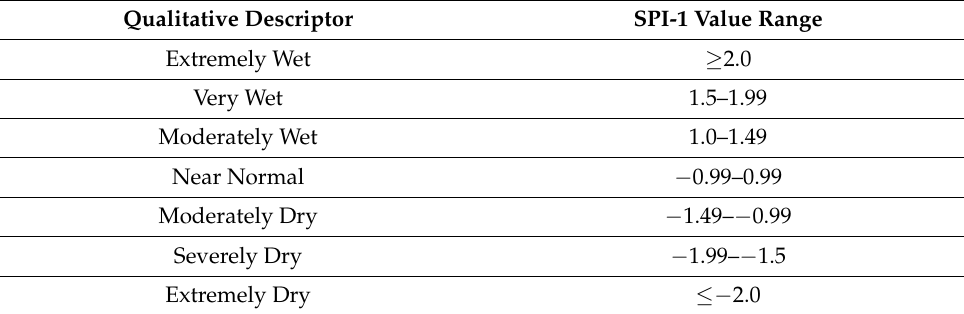
Table 1. Qualitative Descriptors and Associated SPI-1 Value Classification [42].